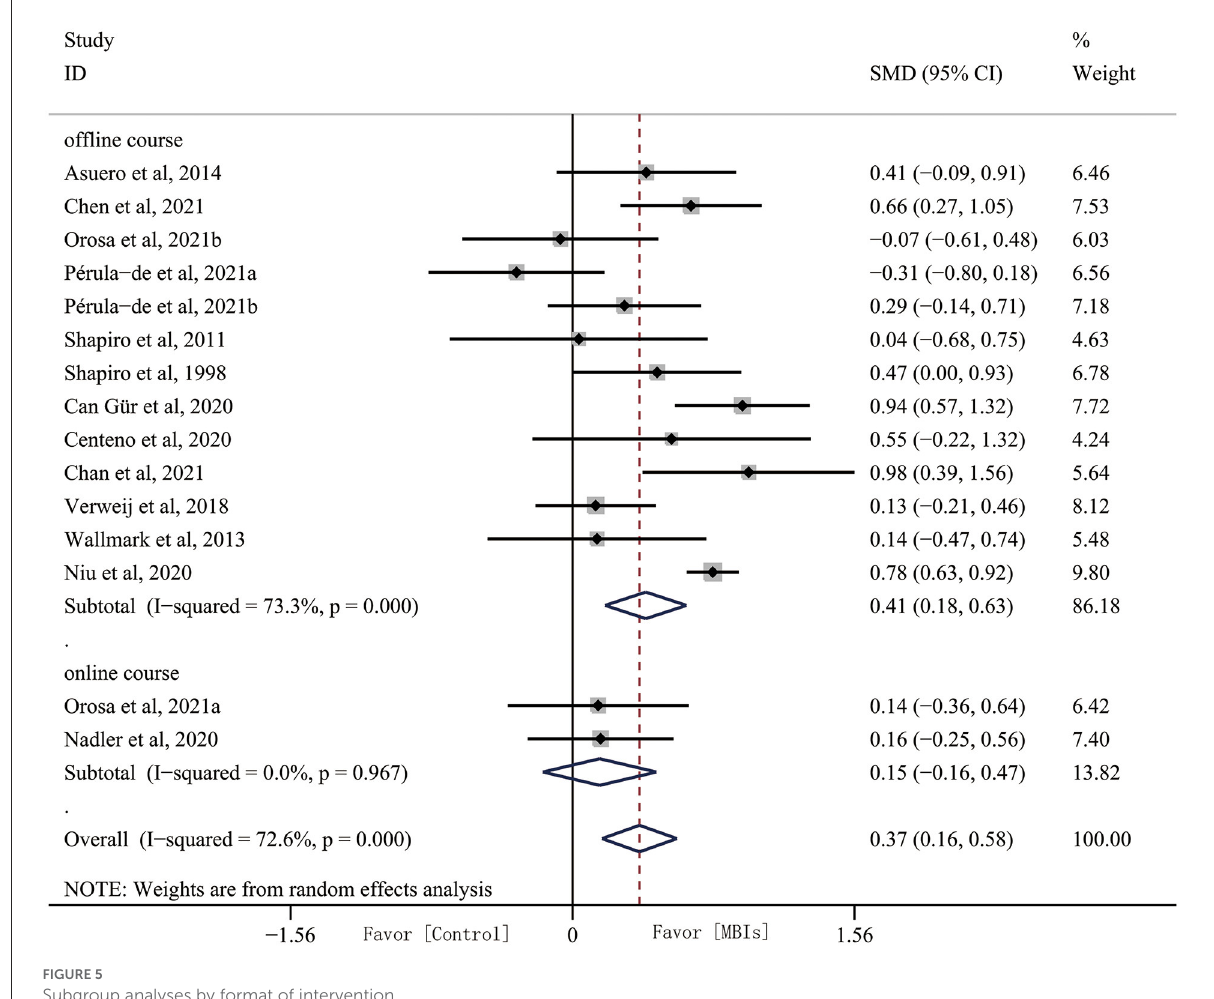
FIGURE5 Subgroup analyses by format of